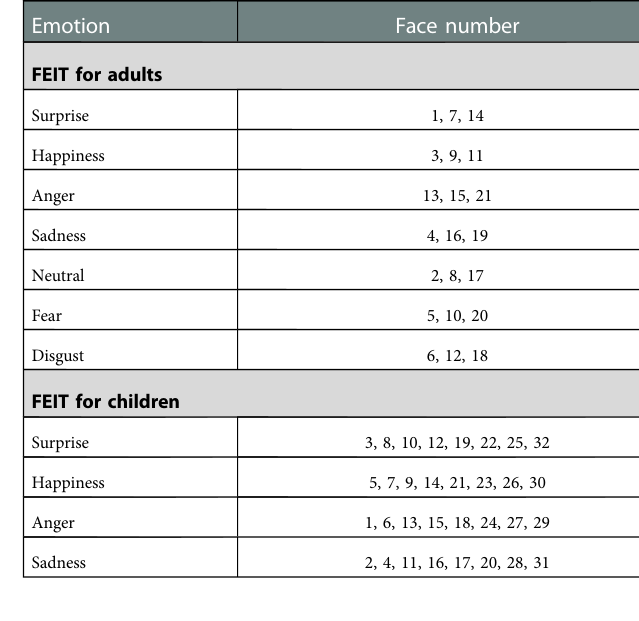
TABLE 7 Correspondence between each face number and the presented emotion in